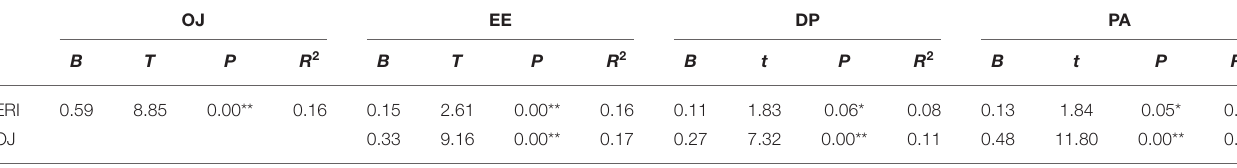
TABLE 3 | Summary of direct effects.